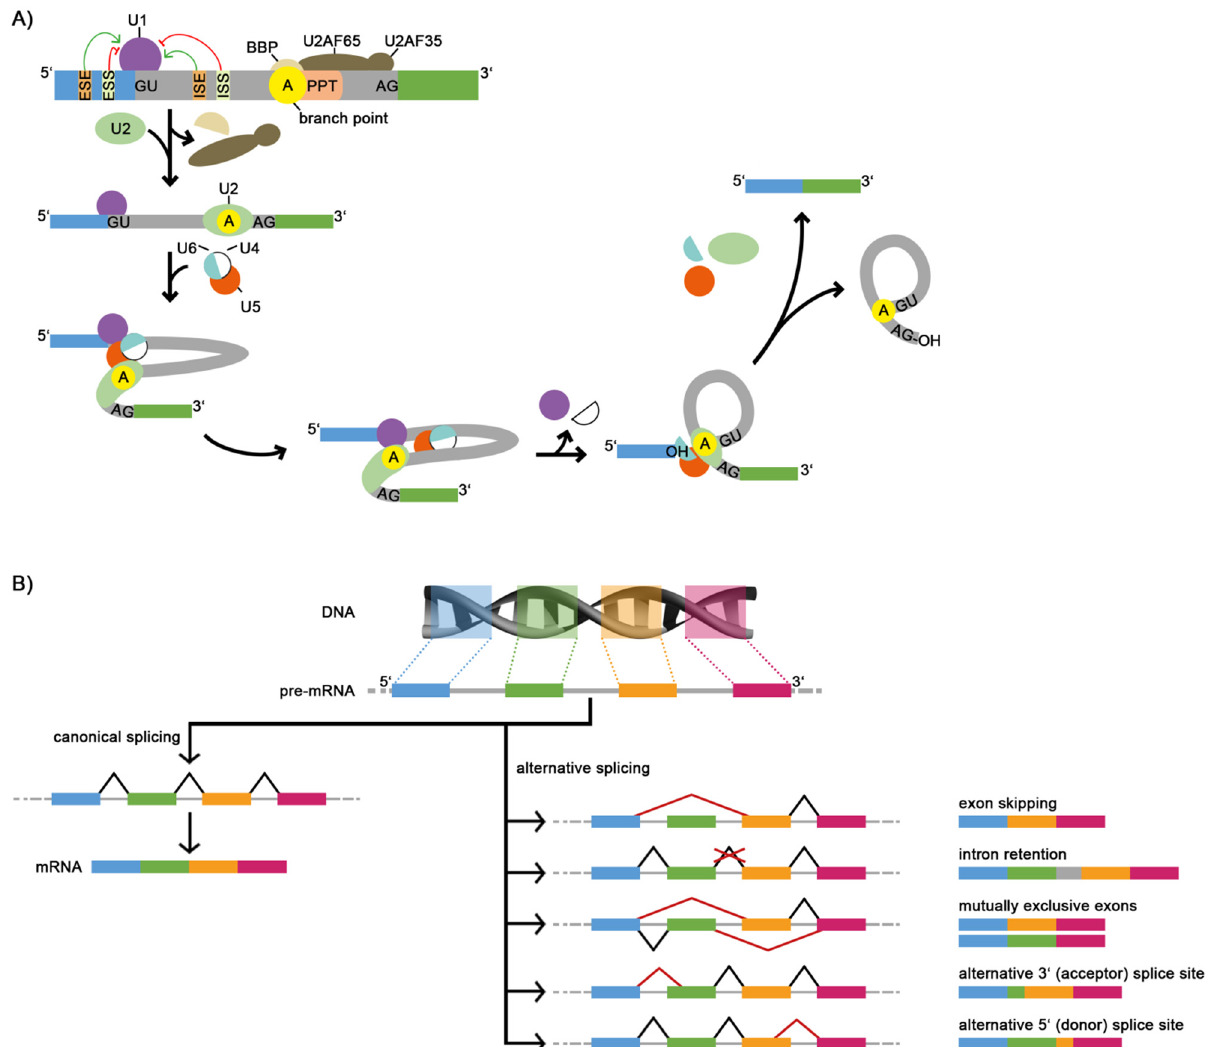
Figure 1. The splicing process and common types of alternative splicing events (ASE). ( A ) Simplified scheme of pre-mRNA splicing with two exons (blue and green boxes) and one intron (gray box). The cis -regulatory elements, namely, 5 ′ and 3 ′ splice sites, which are evolutionarily highly conserved (usually GU and AG, respectively), branch point (yellow circle), polypyrimidine tract (light pink box), and splicing enhancers and silencers (ESE, ESS, ISE, ISS, light orange and light-yellow boxes) assist the spliceosome in recognizing the 5 ′ - and 3 ′ -ends of the intron. Positive regulation is indicated by green arrows, while negative regulation is shown in red. The formation of the spliceosome complex leads to conformational changes of the pre-mRNA. In the first step, the U1 snRNP binds to the GU sequence at the 5 ′ splice site. At the same time, the branch point is bound by the branch point-binding protein (BBP) and the polypyrimidine tract is bound by U2AF. In the next step, the BBP is replaced from the branch point by the U2 snRNP. The interaction of the branch point with U2 leads to the recruitment of the U4/U5/U6 snRNP complex and thereby to the formation of the pre-catalytic spliceosome. The following change of the spliceosome conformation leads to the release of U1 and U4. Then, the interaction of U6 with U2 results in a transesterification, where the guanosine of the 5 ′ splice site is bound to the adenosine in the branch point. In a second transesterification step, the exons are joined together. The spliced-out intron (lariat structure) is degraded, and the U2, U5, and U6 snRNPs are released to catalyze the following splicing process. ( B ) The canonical (left) and alternative (right) splicing paths with corresponding alternative splicing events that can be distinguished. The blue-, green-, orange-, and pink-colored boxes represent 4 different exons in the 5 ′ to 3 ′ direction, while the gray lines in between represent introns. The constitutive path of intron removal (black lines) and alternative paths (red lines) are indicated. ASE: alternative splicing events, BBP: branch point-binding protein, ESE: exonic splicing enhancer, ESS: exonic splicing silencer, ISE: intronic splicing enhancer, ISS: intronic splicing silencer, PPT: polypyrimidine tract, snRNP: small nuclear ribonucleoprotein, U2AF: U2 auxiliary factor.